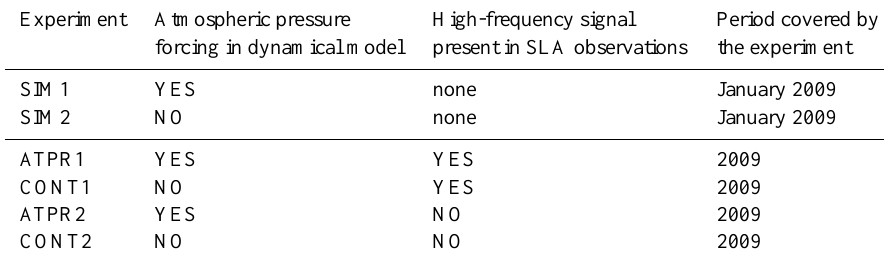
Table 1. Summary of